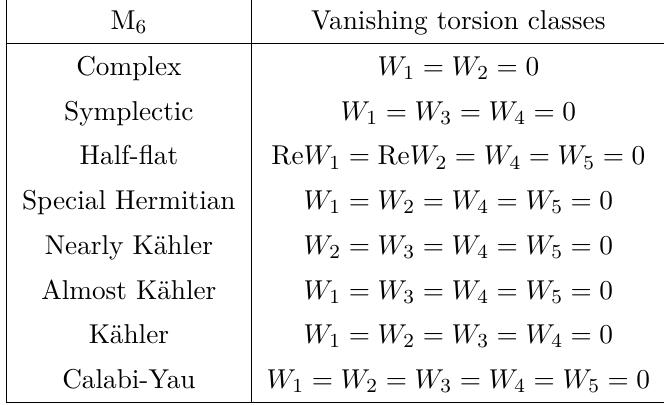
Table 2 . Some notable SU(3)-structure six-manifolds in terms of vanishing torsion classes.